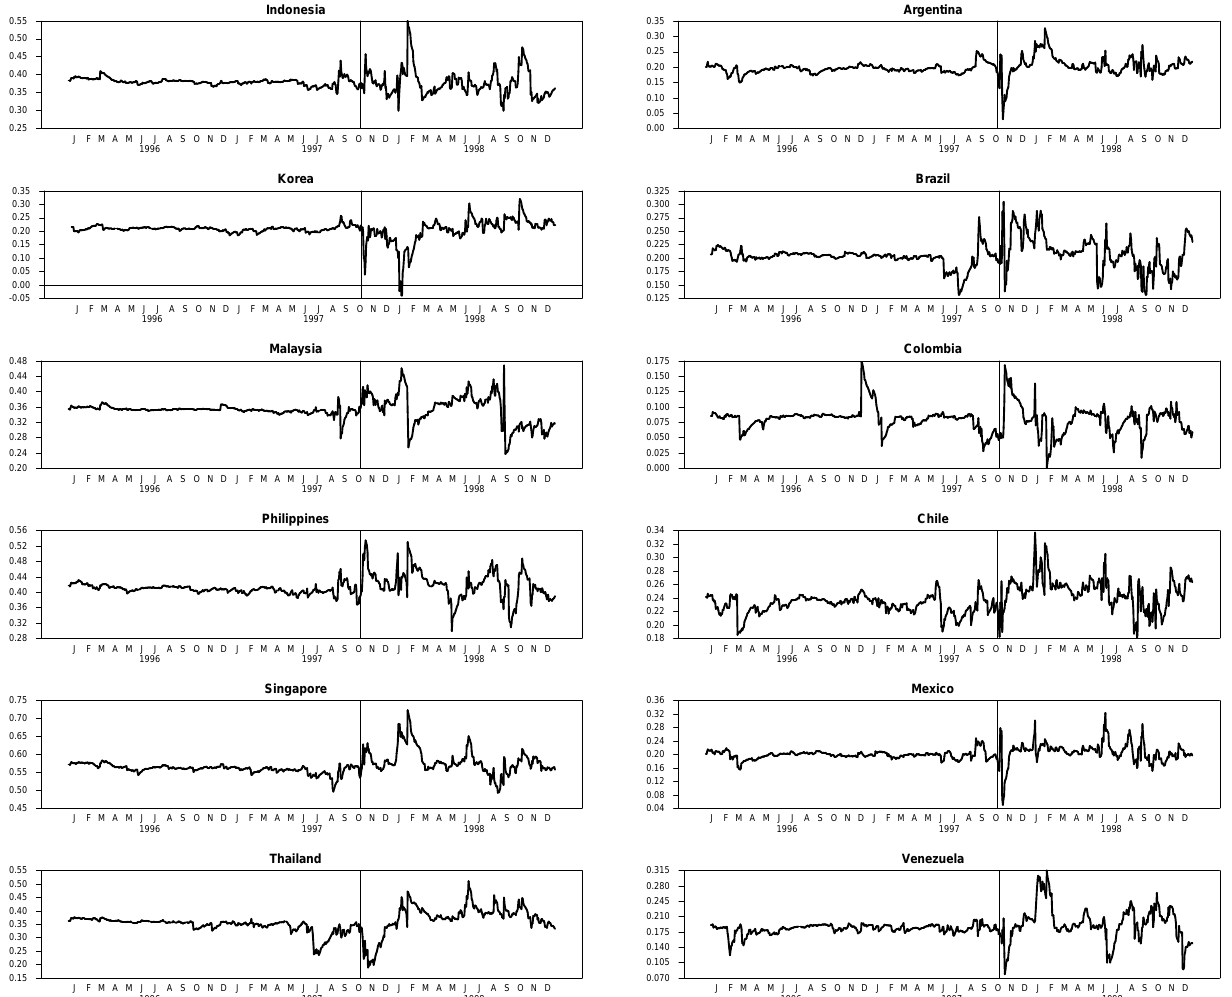
Figure 3. The dynamic correlation estimation for the Asian “flu” crisis (Source of contagion: Hong Kong). The vertical continuous line represents the break date: 17 October